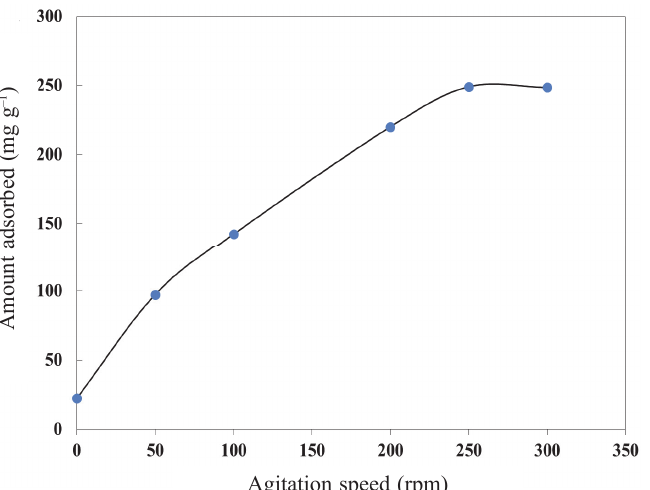
Table 1 – The pseudo first order and pseudo second order kinetic constants of chromate removal by IL-rGO adsorbent